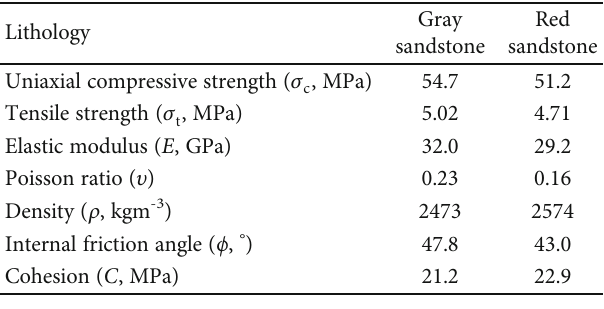
Table 1: Physical and mechanical properties of gray sandstone and red sandstone.